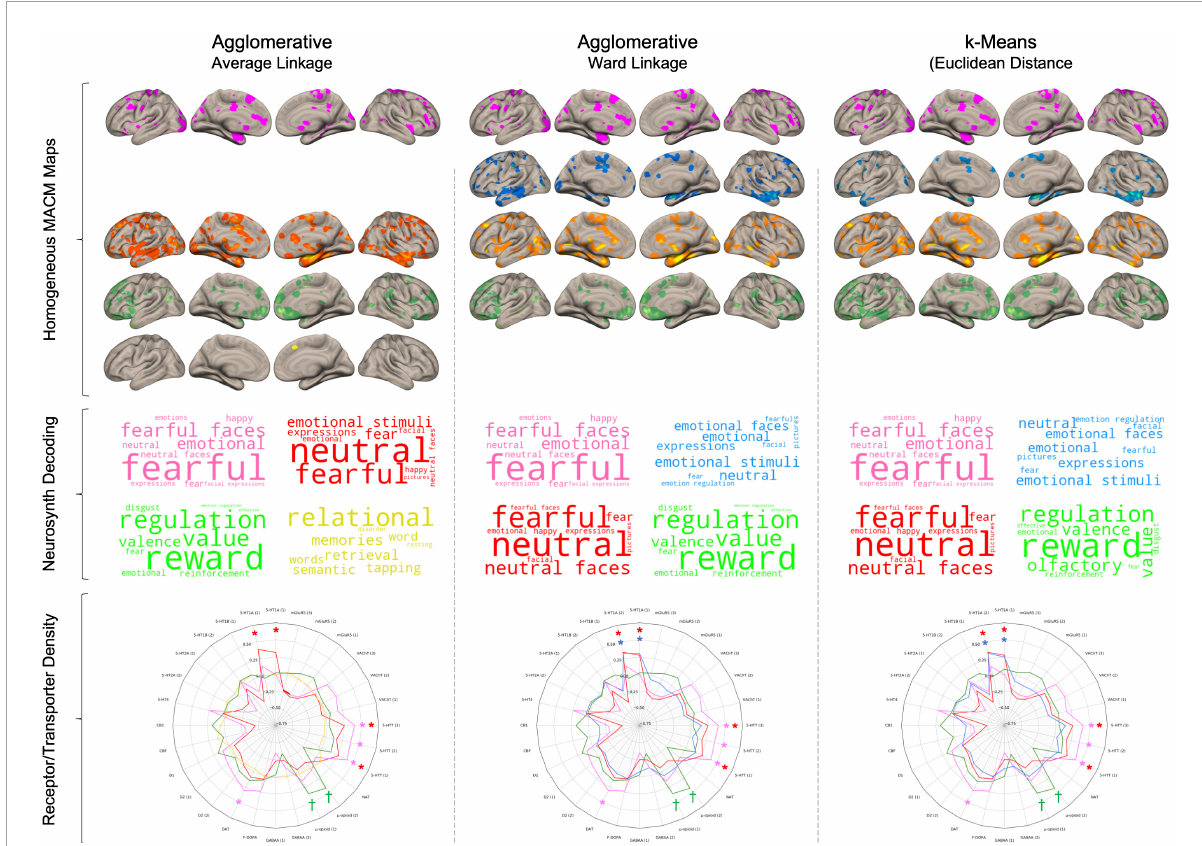
FIGURE4 Results from the three different clustering algorithms. Rows represent cluster for each of the three algorithms. For each cluster, its respective brain network was produced by summing the thresholded and binarized lesion-specific networks that were assigned to the cluster. Wordclouds were generated by Neurosynth meta-analytic terms. Larger font represents stronger correlation. In Radar charts, Daggers ( † ) represent p < 0.001 uncorrected and asterisks (*) represent pFDR <